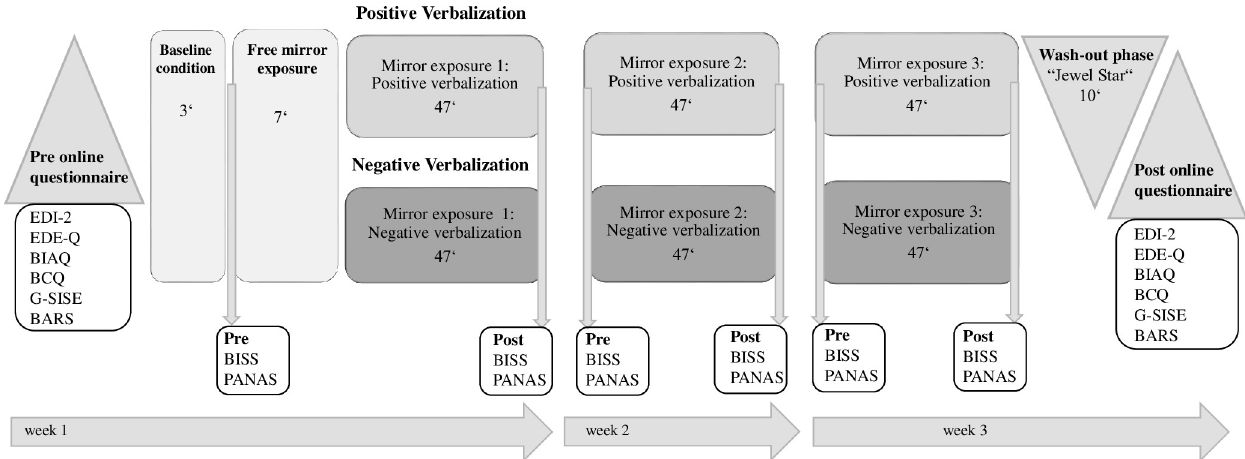
Fig 2. Procedure of the present study. EDI-2 = Eating Disorder Inventory-2; EDE-Q = Eating Disorder Examination Questionnaire; BIAQ = Body Image Avoidance Questionnaire; BCQ = Body Checking Questionnaire; G-SISE = German Single-Item Self-Esteem; BARS = Body Areas Rating Scale; BISS = Body Image States Scale. PANAS = Positive and Negative Affect